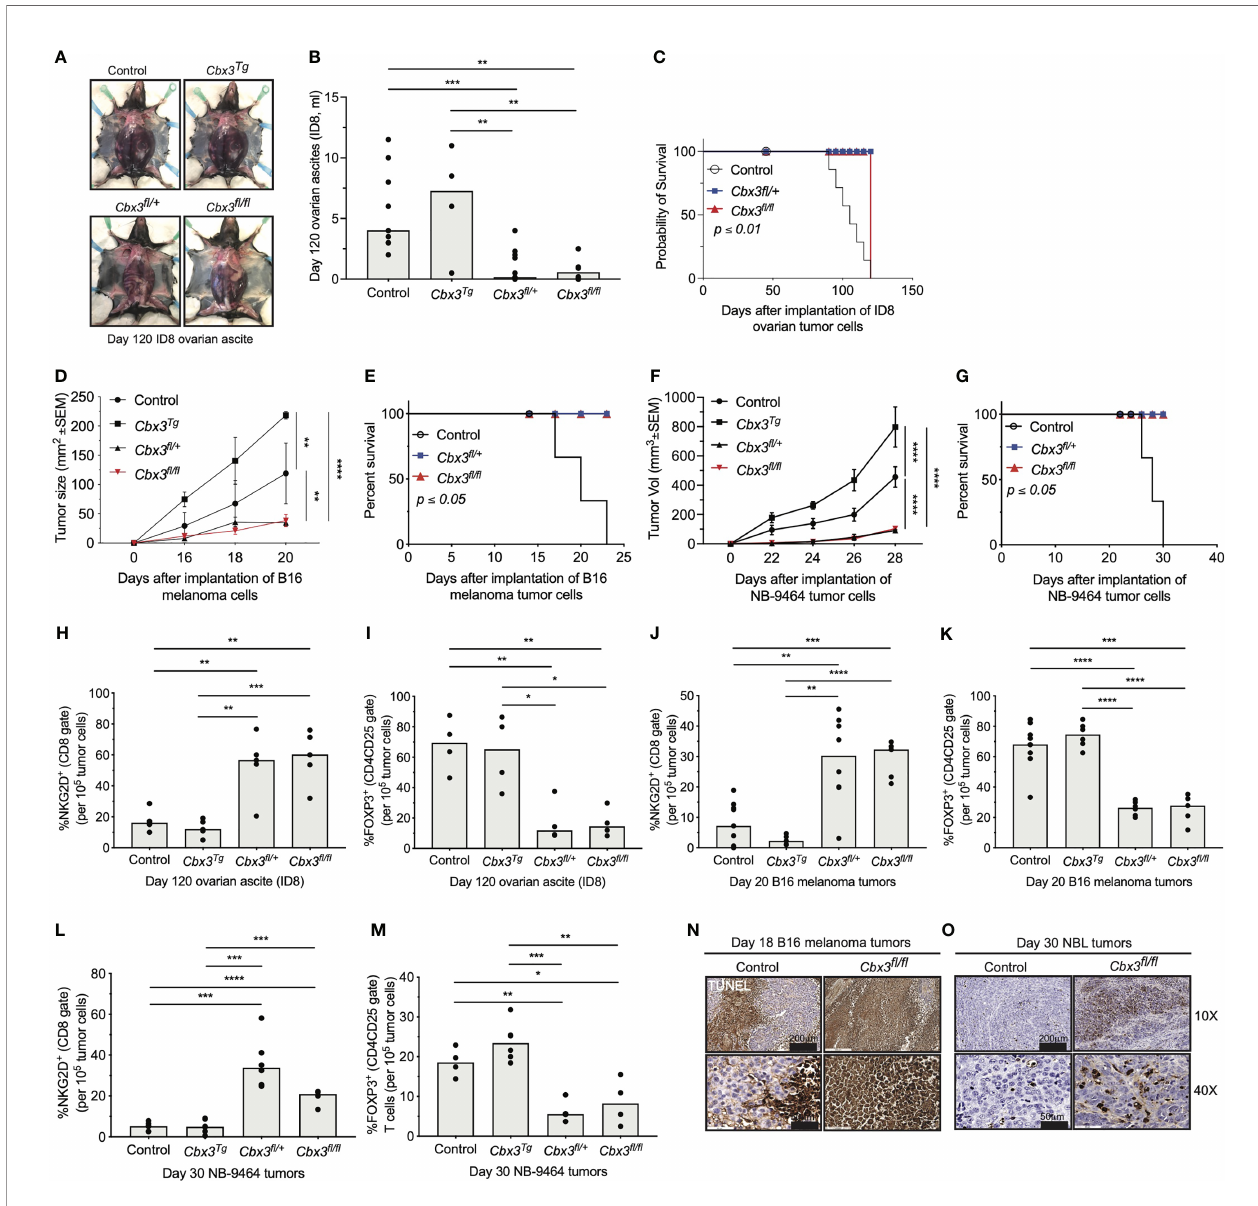
FIGURE 3 | Cbx3 /HP1 g -de fi cient CD8 + effector T cells can persist and cause tumor rejection. (A) Ascites from control (CD8 a -Cre or wt), Cbx3 Tg , Cbx3 fl /+ and Cbx3 fl / fl mice (X axis) were visualized on day 120 after IP injection of mouse ID8 ovarian tumor cells; Cbx3 Tg : Cbx3/ HP1 g T-cell-restricted expression driven by the human Cd2 promoter; Cbx3 fl /+ and Cbx3 fl / fl : CD8 + T-cell-restricted deletion of Cbx3/ HP1 g using the CD8 a -Cre mouse. (B) Ovarian ascites of mice in (A)